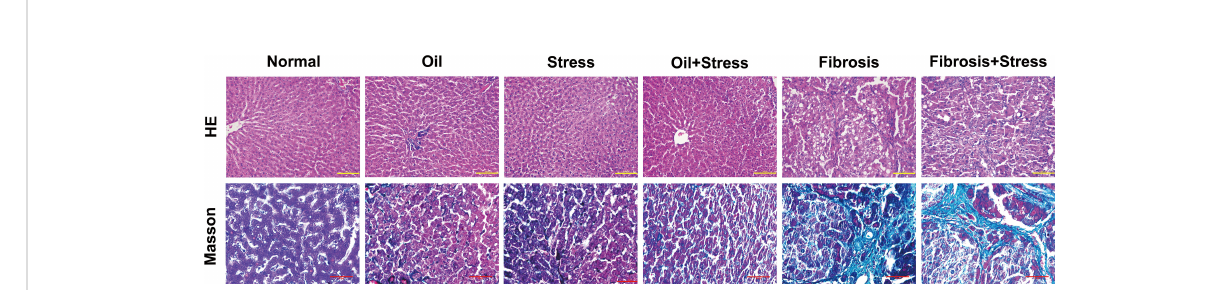
FIGURE 1 HE and Masson staining of liver tissue in rats. (up) HE staining of liver tissue. The degeneration and necrosis of hepatocytes and in fl ammatory cell in fi ltration occurred in liver tissue in the stress group and oil+Stress group, and were further exacerbated in the fi brosis group and fi brosis+stress group. Scale bar: 100um. (down) Masson staining of collagen (green) in liver tissue. Very small collagen fi bers formed in liver tissue in the stress group and oil+stress group, numerous collagen fi bers were deposited in liver tissue in the fi brosis group and fi brosis+stress group. Scale bar: 50um.